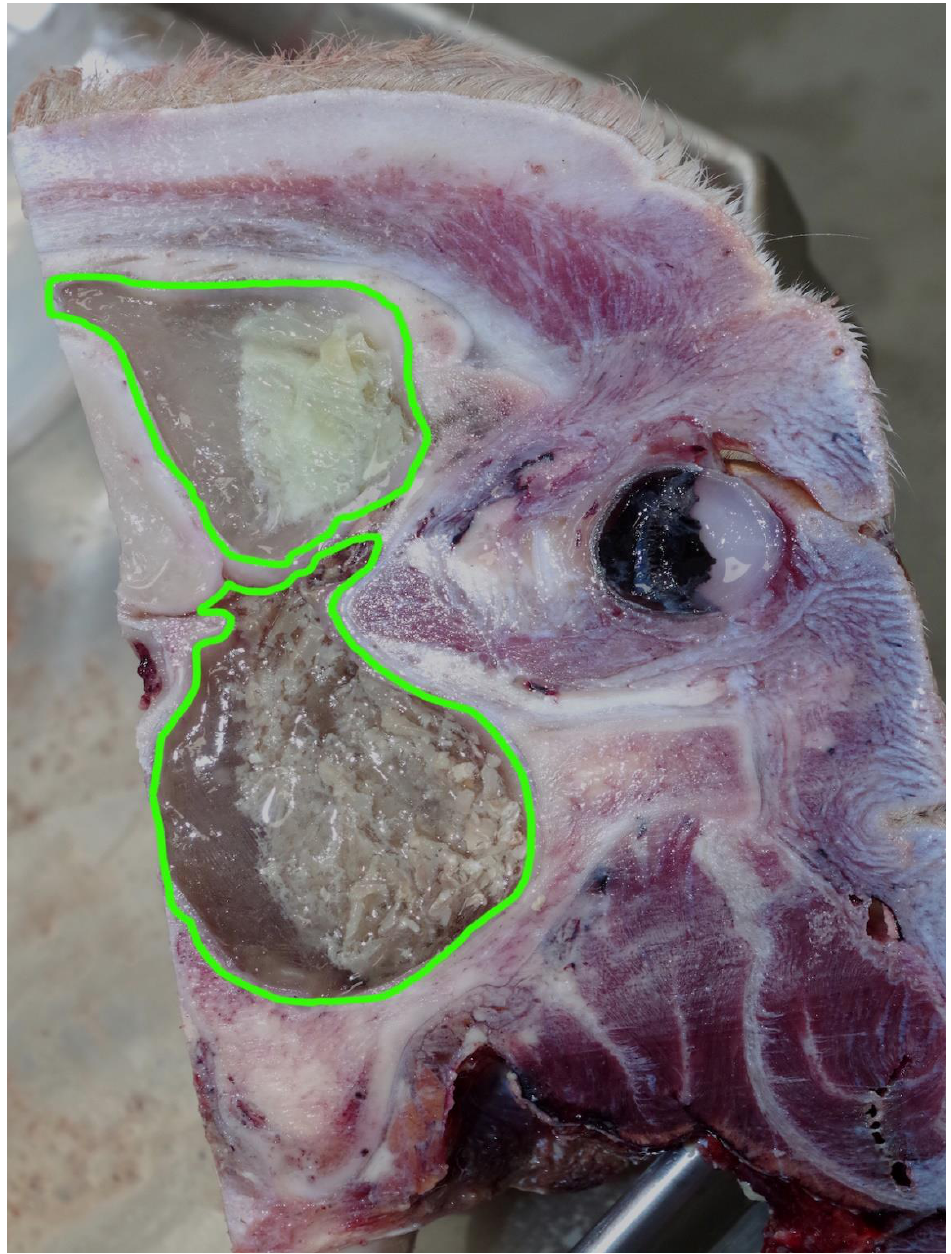
Figure 9. A frontal slice of the head (right side) through ocular orbit demonstrating chronic fibrous sinusitis with pus formation highlighted in green and inflammatory reaction apparent in the bone